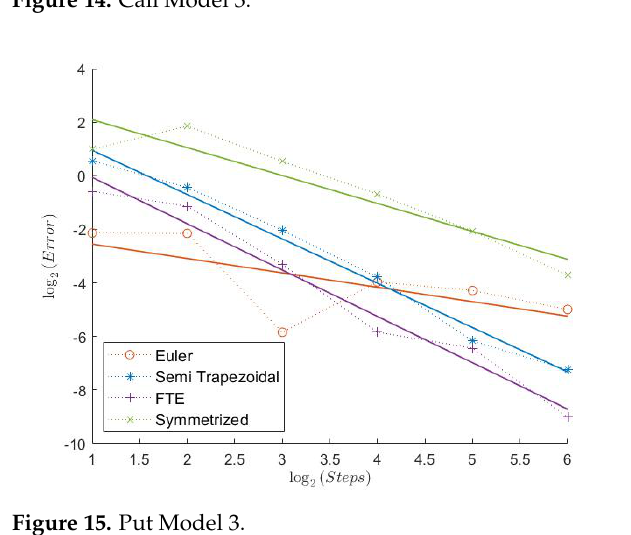
Figure 15. Put Model 3.